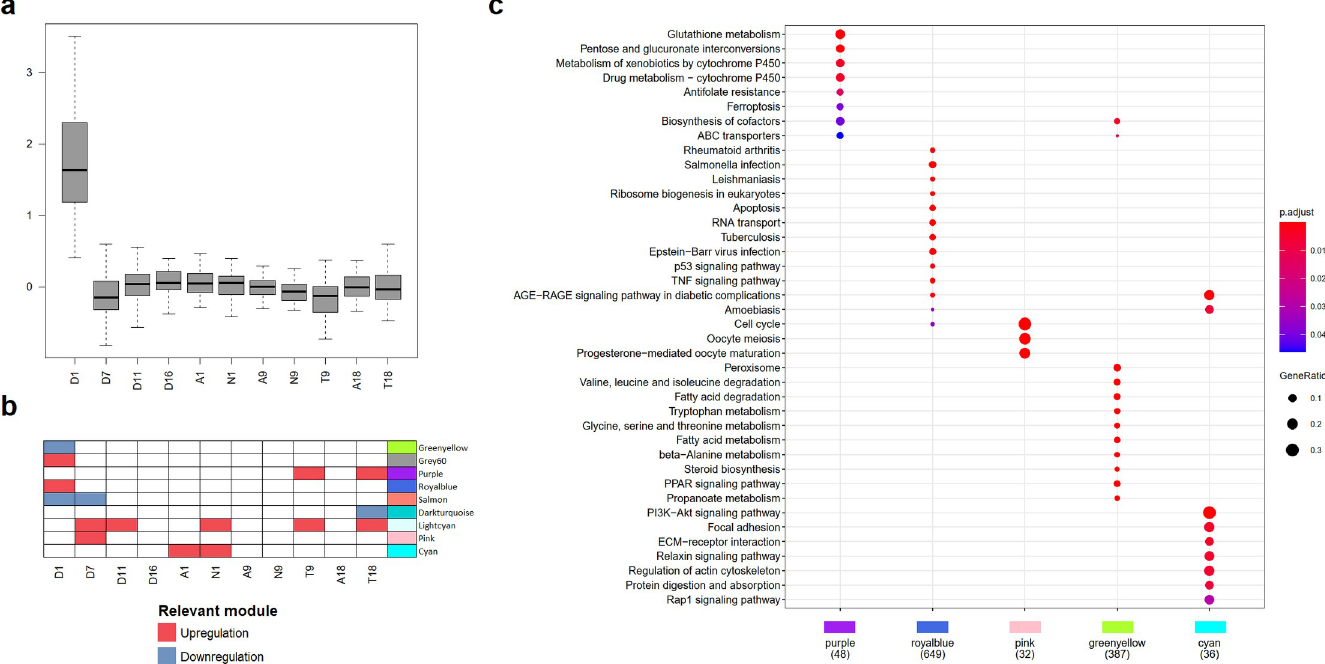
Fig 4. Transcriptomic modules correlate with specific stages of HCC development indicating a potentially relevant role for these modules. ( a ) Grey60 transcriptomic module was upregulated during DEN administration in day one. ( b ) Relevant modules in specific stages of HCC development, upregulated modules are shown in red color, whereas blue shows downregulated modules. ( c ) KEGG pathways over-represented in transcriptomic modules, numbers under module color are the number of genes used in over-representation pathway analysis. Module identification was performed in R using WGCNA package and over-representation pathway analysis, using clusterProfiler package, considering a p value < 0.05 and q value < 0.1.